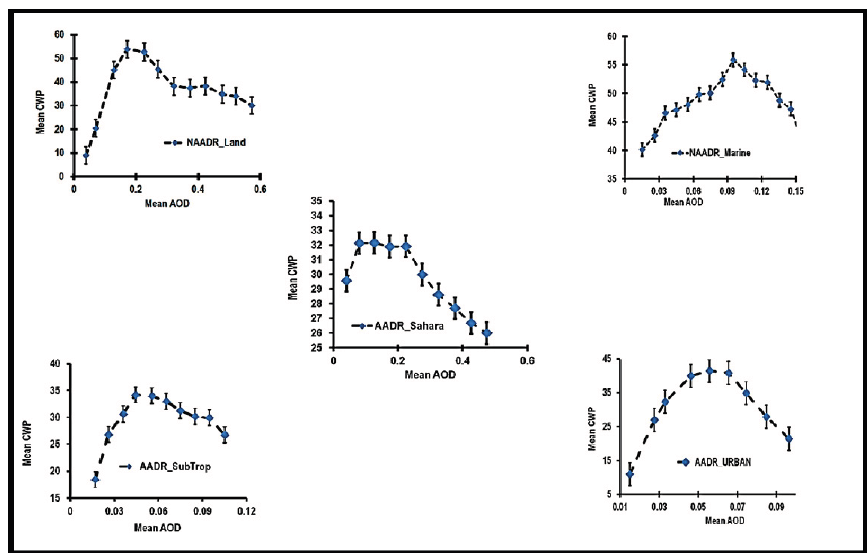
Figure 6. Responses of cloud water path (CWP) to increasing aerosol optical depth (AOD) for all five study regions. CWP initially increases to a maximum followed by a decrease in each case. CWP sensitivities during moistening and drying are calculated from the response curves as the slopes of mean CWP vs. mean AOD during both moistening and drying. For each average point shown above, the standard deviation is shown as error bars.